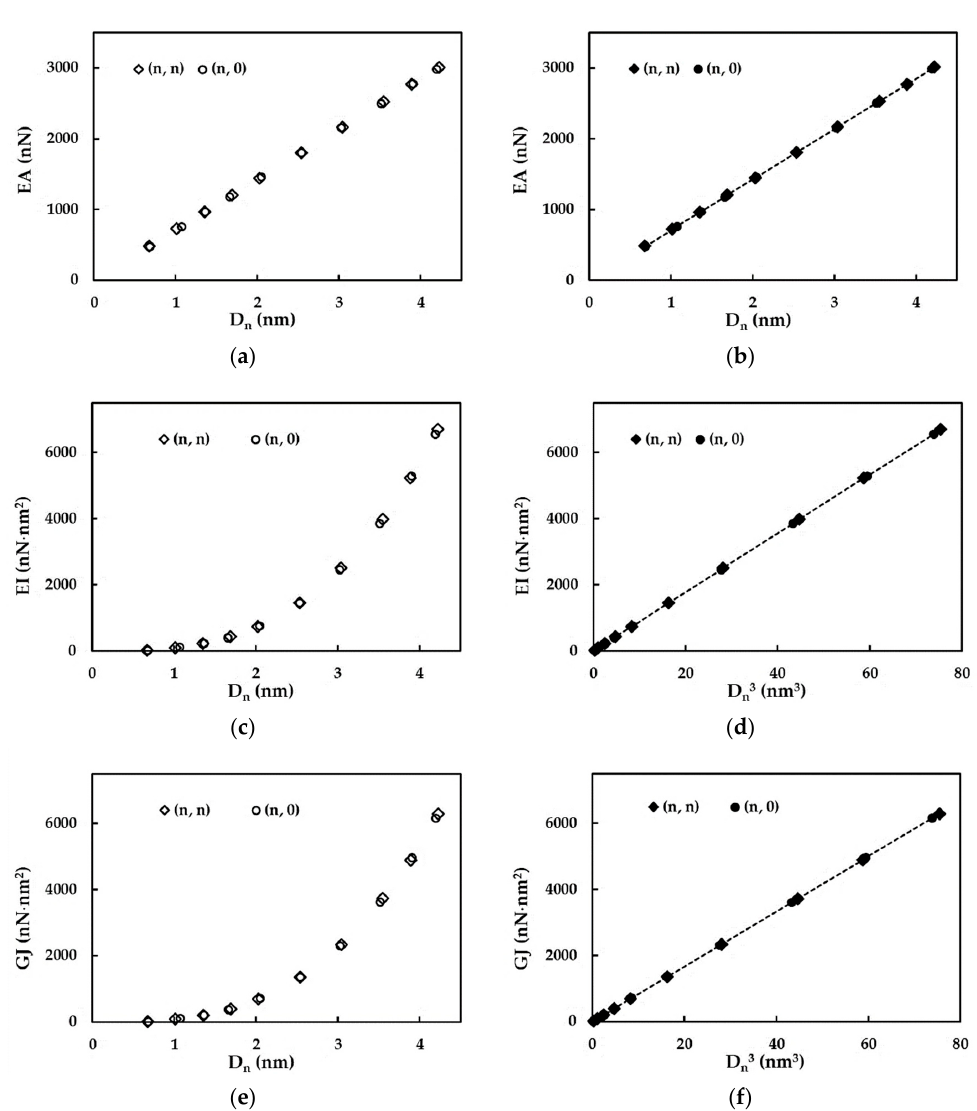
Figure 3. Evolutions of ( a , b ) tensile, EA, ( c ) bending, EI, and ( e ) torsional, GJ, rigidities as a function of the nanotube diameter, D n ; ( d ) bending, EI, and ( f ) torsional, GJ, rigidities and as a function of D n3 for non-chiral SWSiCNTs. The results refer to the nanotubes in Table 2. To investigate the accuracy of the aforementioned analytical expressions for the eval- uation of the three rigidities, Figure 4 compares the EA, EI and GJ rigidities obtained from FE analysis, using Equations (6)–(8), and those evaluated by Equations (19)–(21). As can be seen, the average difference between the EA, EI and GJ values acquired from FE anal- yses and those calculated analytically are 0.20%, 0.21% and 0.32% for EA, EI and GJ rigid- ities, respectively.